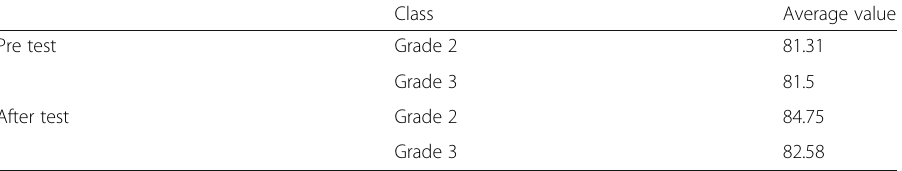
Table 3 Comparison of vocabulary ability test results before and after the experiment